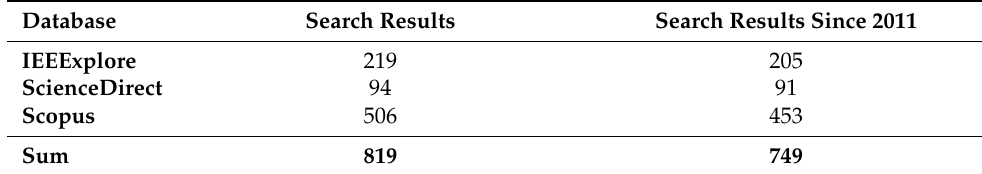
Table 1. Number of search results.